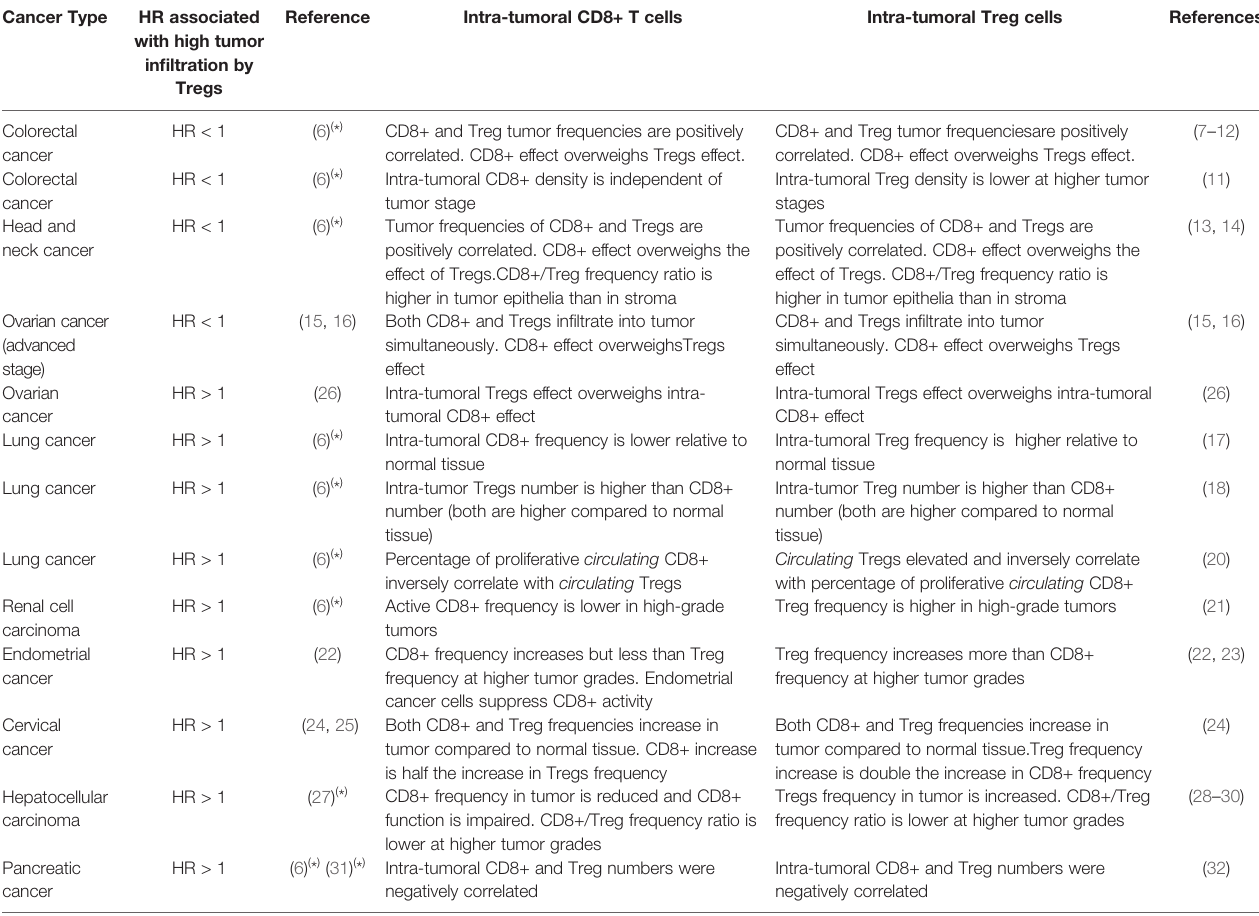
TABLE 1 | Hazard ratios associated with Tregs in fi ltration and the related lymphocyte frequencies in the TME. Cancer Type HR associated with high